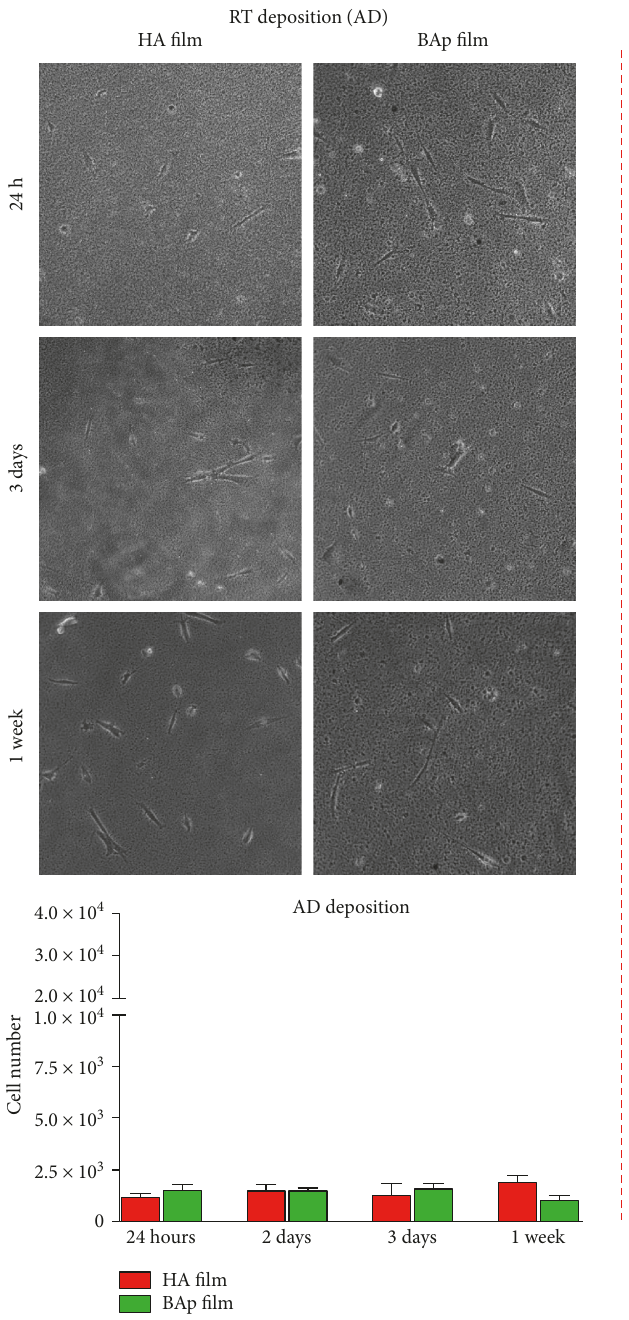
Figure 2: Representative phase contrast images showing hDPSC adhesion after 24h of culture and cell proliferation on HA and BAp fi lms after room temperature deposition (AD) and after 400 ° C deposition (HT) up to one week. Histograms represent the growth kinetics of hDPSCs cultured on di ff erent fi lms at di ff erent time points. ∗ P < 0 05 , ∗∗∗ P < 0 001 hDPSCs cultured on BAp_HT versus hDPSCs cultured on HA_HT fi lms. Scale bar: 10 μ